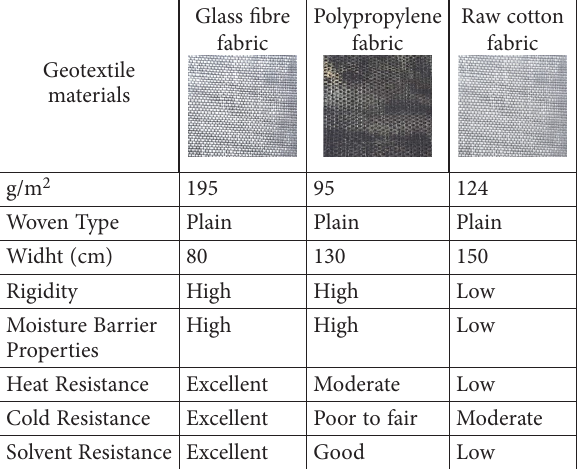
Figure 1. The weight, some properties and visuals of the geotextile materials featured used in the experiment